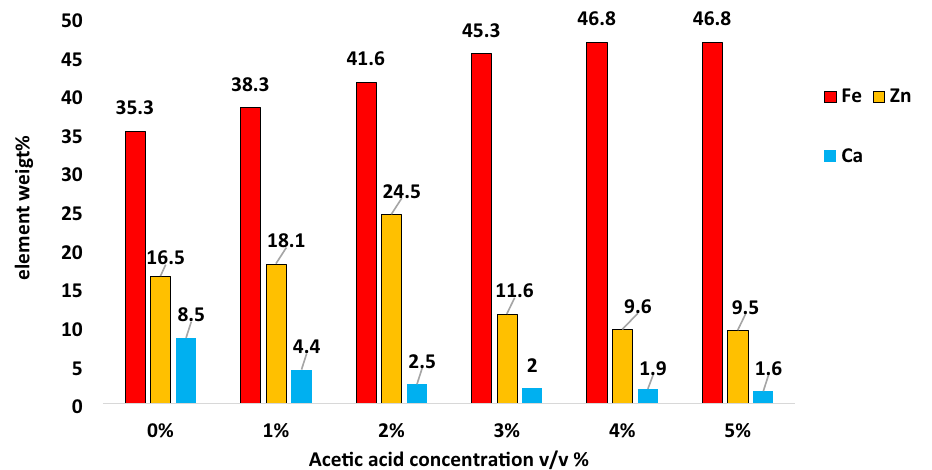
Figure 2. Effect of acetic acid treatment on chemical composition of EAFD.